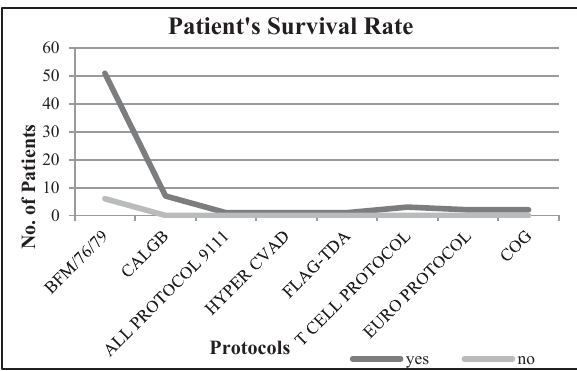
Fig-3: Survival of patients according to a treatment protocol